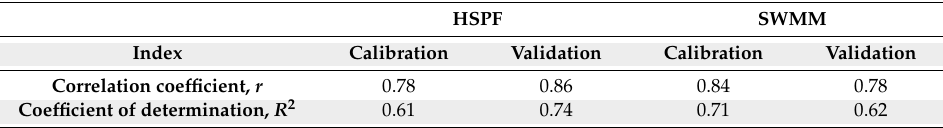
Table 4. Results of the model fitness analysis for daily flow.